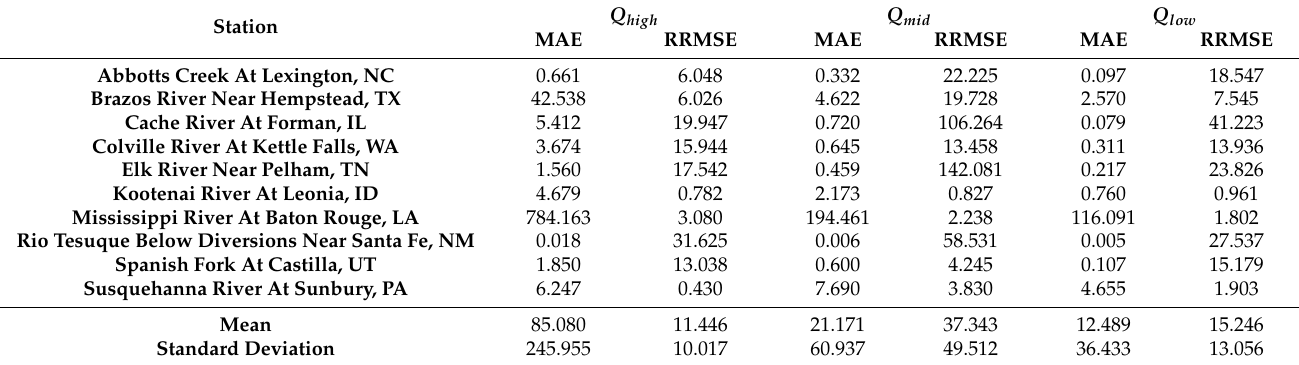
Table 8. The table lists the Mean Absolute Error (MAE) and Relative Root Mean Squared Error (RRMSE) for the high, mid, and low flows within the stations. The high flows are the flows equal to or above the 80th percentile, the low flows are the flows equal to or below the 20th percentile, while in between high and low flows are the mid flows. The unit of Q is m 3